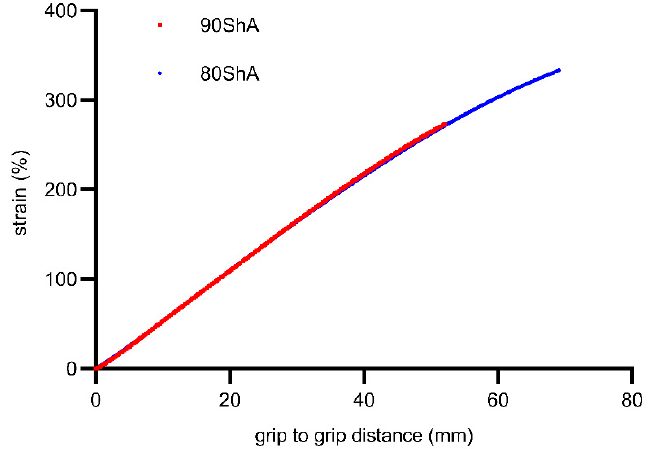
Figure 3. Experimental set-up for pure shear (PS) testing using Instron and MTS test system .